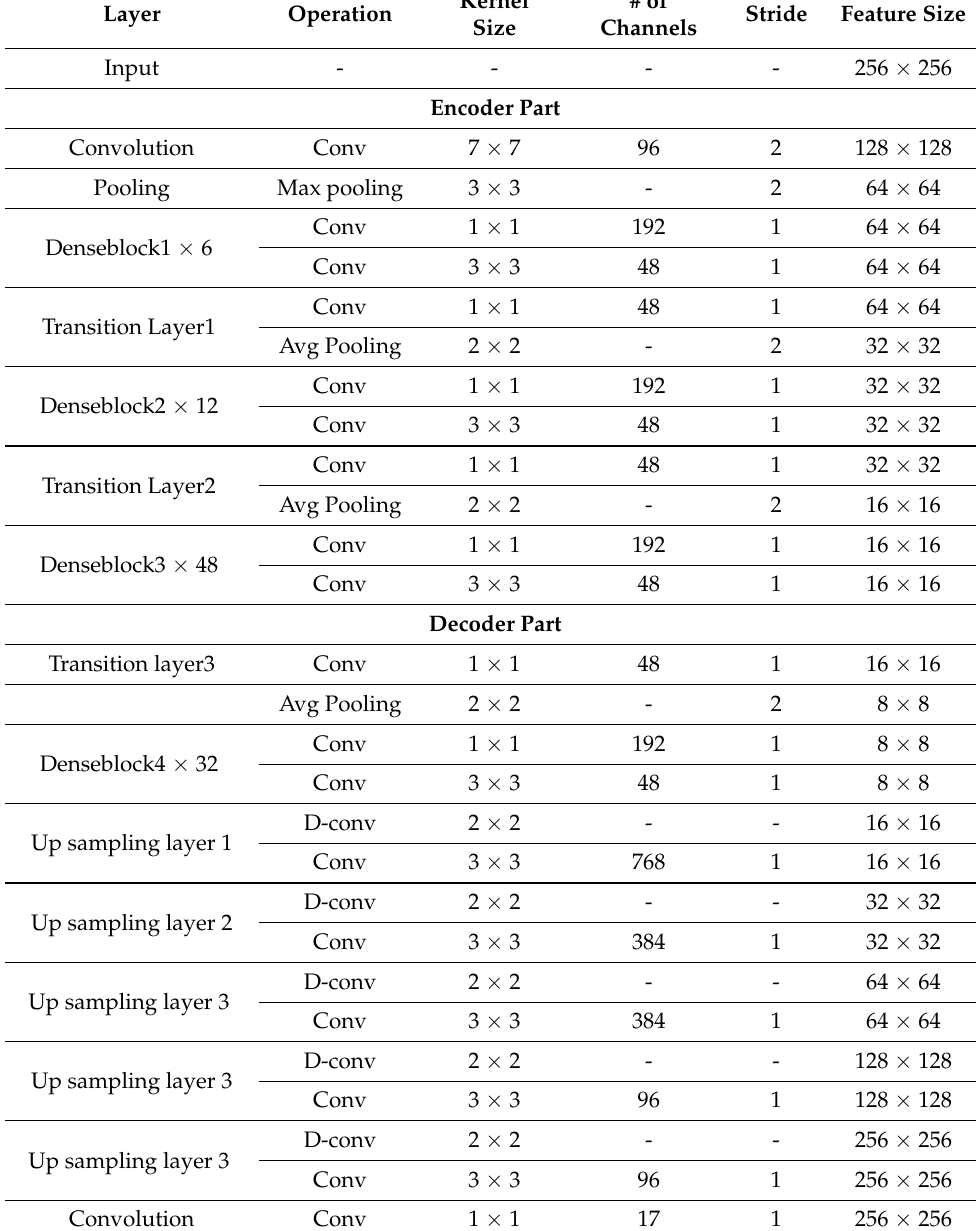
Table 1. Architecture of the proposed network. The network consists of two parts, i.e., encoder and decoder. The encoder part consists of denseblocks and transition layers. The decoder part consists of upsampling layers. Denseblock i × d represents denseblock i , where d represents the repetition of